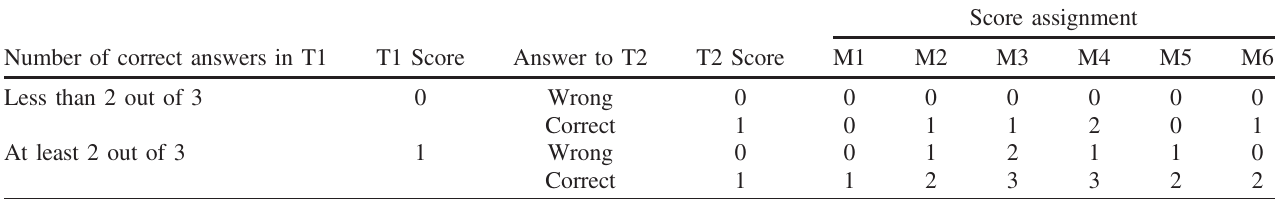
TABLE III. QME scoring